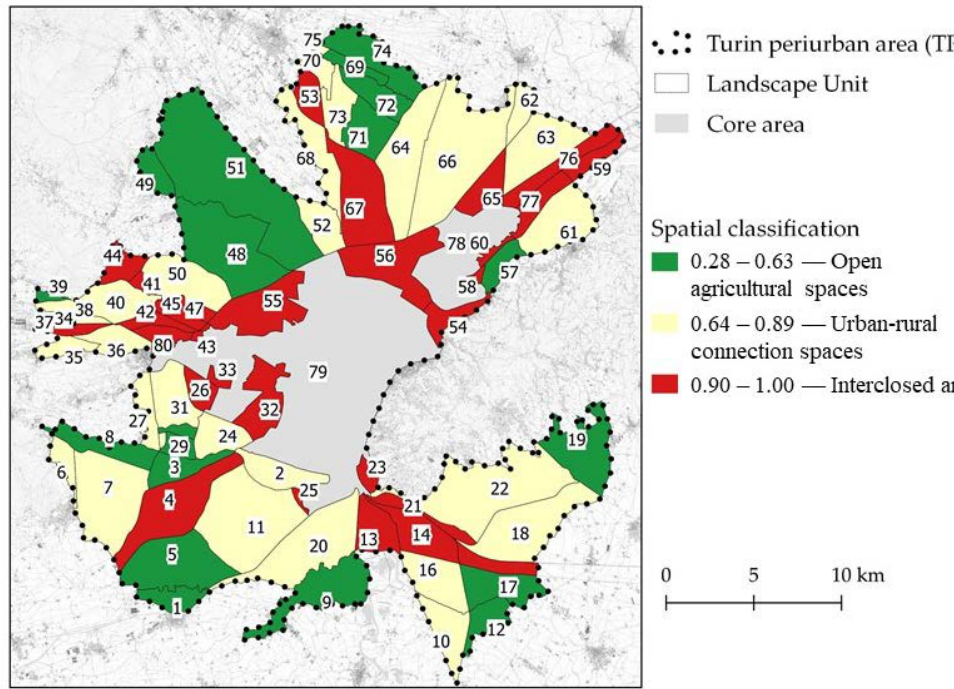
Figure 5. Map of the spatial classification of peri-urban landscape units.